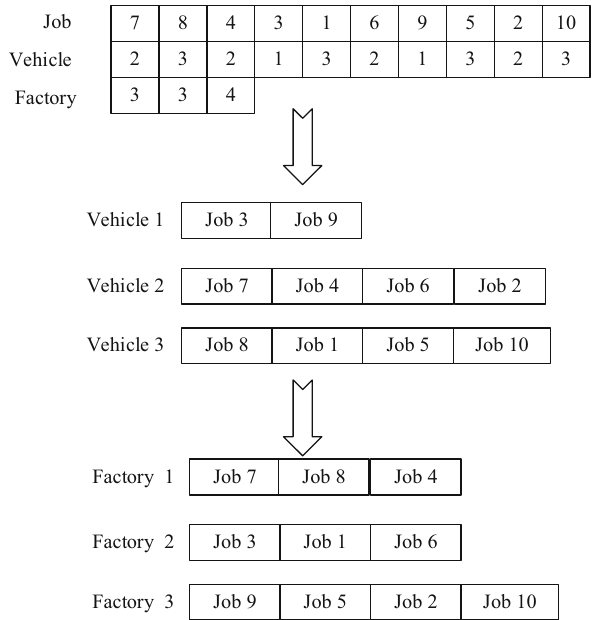
tasks sequencing at production stage, and batch delivery of finished jobs with capacity limited vehicles at the distribu- tion stage. A matrix of three rows is used to represent a chromosome. The n numbers randomly arranged in the first row show the processing sequence of n workpieces in a dis- tributed hybrid flow shop. The second row represents the delivery vehicle selected by different jobs which are deter- mined in the first row. The last row represents the production plant that are chosen by jobs. A feasible solution is shown in Fig.